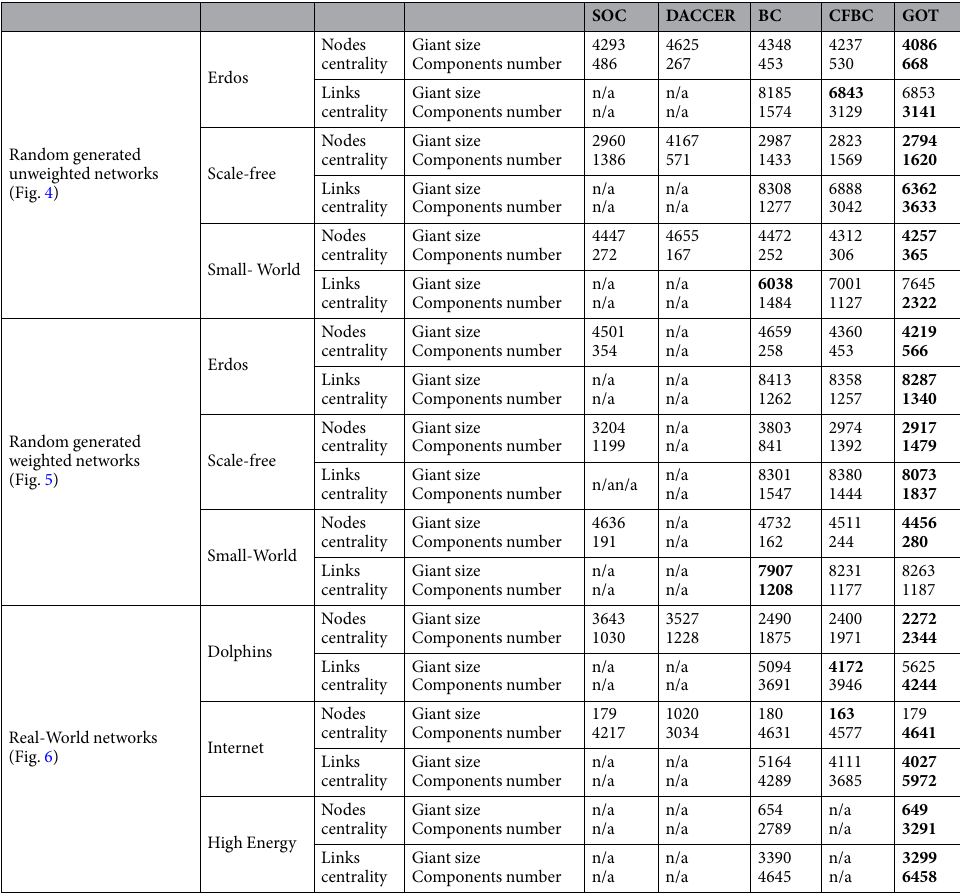
Table 2. Experiments summary. Area under the curve (AUC), rounded to the nearest integer, computed for each metric from each subplot from Figs 4–6. The bold values represent the best performer for that specific scenario, while “n/a” means that the metric is not suitable for that specific